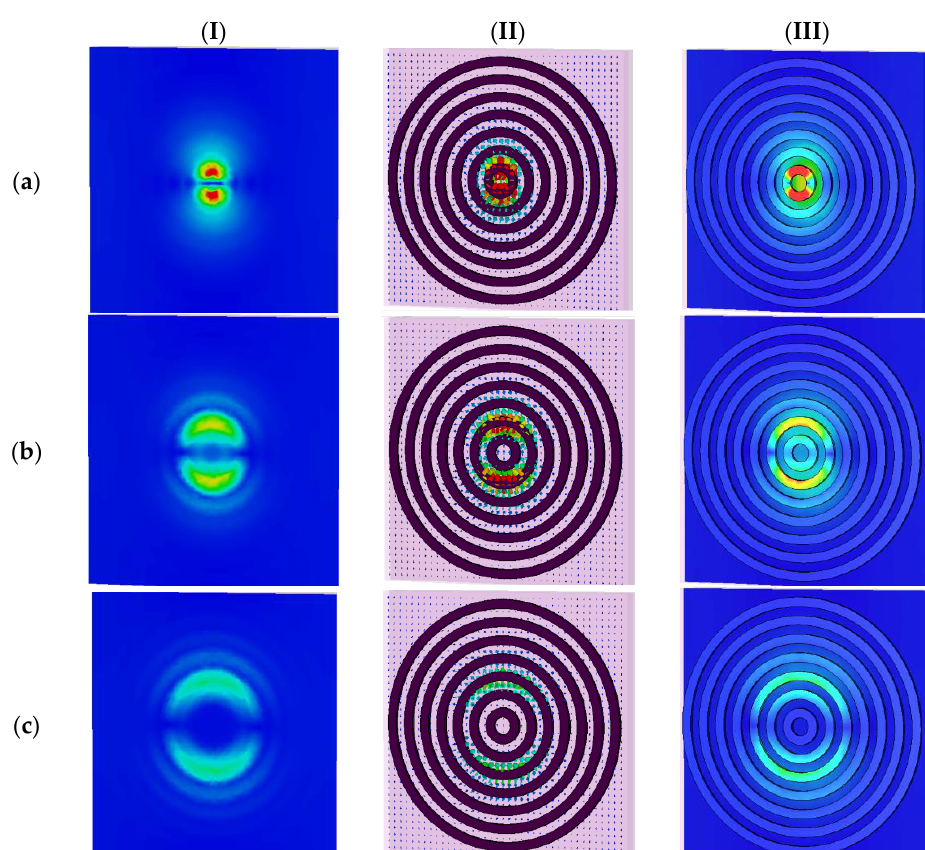
Figure 6. The electric field distributions and surface current energy densities on the top and bottom layer of the structure in XY-plane at different resonance frequencies. Column (I) shows electric field distributions at Z = 36 nm. Column (II) shows surface current electric energy densities. Column (III) shows electric field distributions at Z = 25 nm. For unit cell G at a frequency of: ( a ) f 1 = 1.55 THz, ( b ) f 2 = 0.81 THz, ( c ) f 3 = 0.53 THz, ( d ) f 4 = 0.39 THz, ( e ) f 5 = 0.31 THz, ( f ) f 6 = 0.25 THz, and ( g ) f 7 = 0.2 THz.